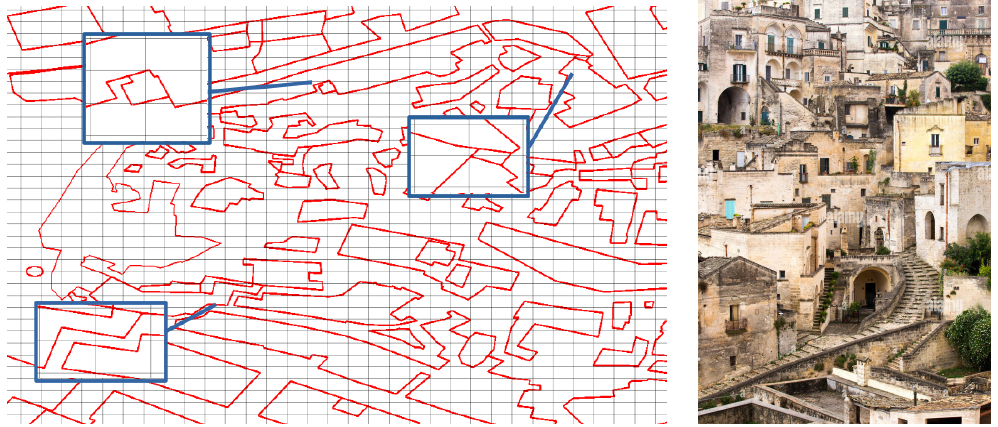
Figure 4. On the ( left ): a view of the DTM/DSM grid (corresponding to the pixels of the GeoTIFF file) with impressed building boundaries in the Sassi area. As can be seen, the cell grid size is too large to recognise correctly streets and to diversify close buildings because their points fall within the same pixel. For example, the elevation associated to the small buildings in the top highlighted areas will often be the same of the adjacent ones. The same applies to the streets such as the one in the lower highlighted area, where huge differences in the elevation of the points composing the street may happen if adjacent buildings’ bases have substantial differences in elevation. On the ( right ): some alleyways of the Sassi